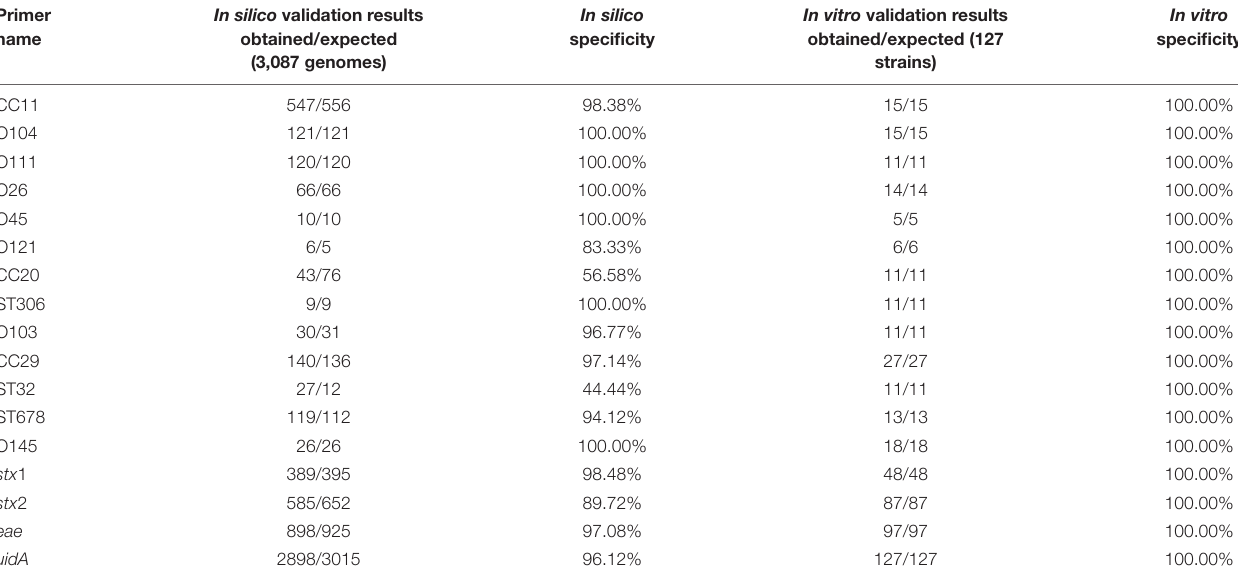
TABLE 4 | In silico and in vitro specificity of the predicted biomarkers.